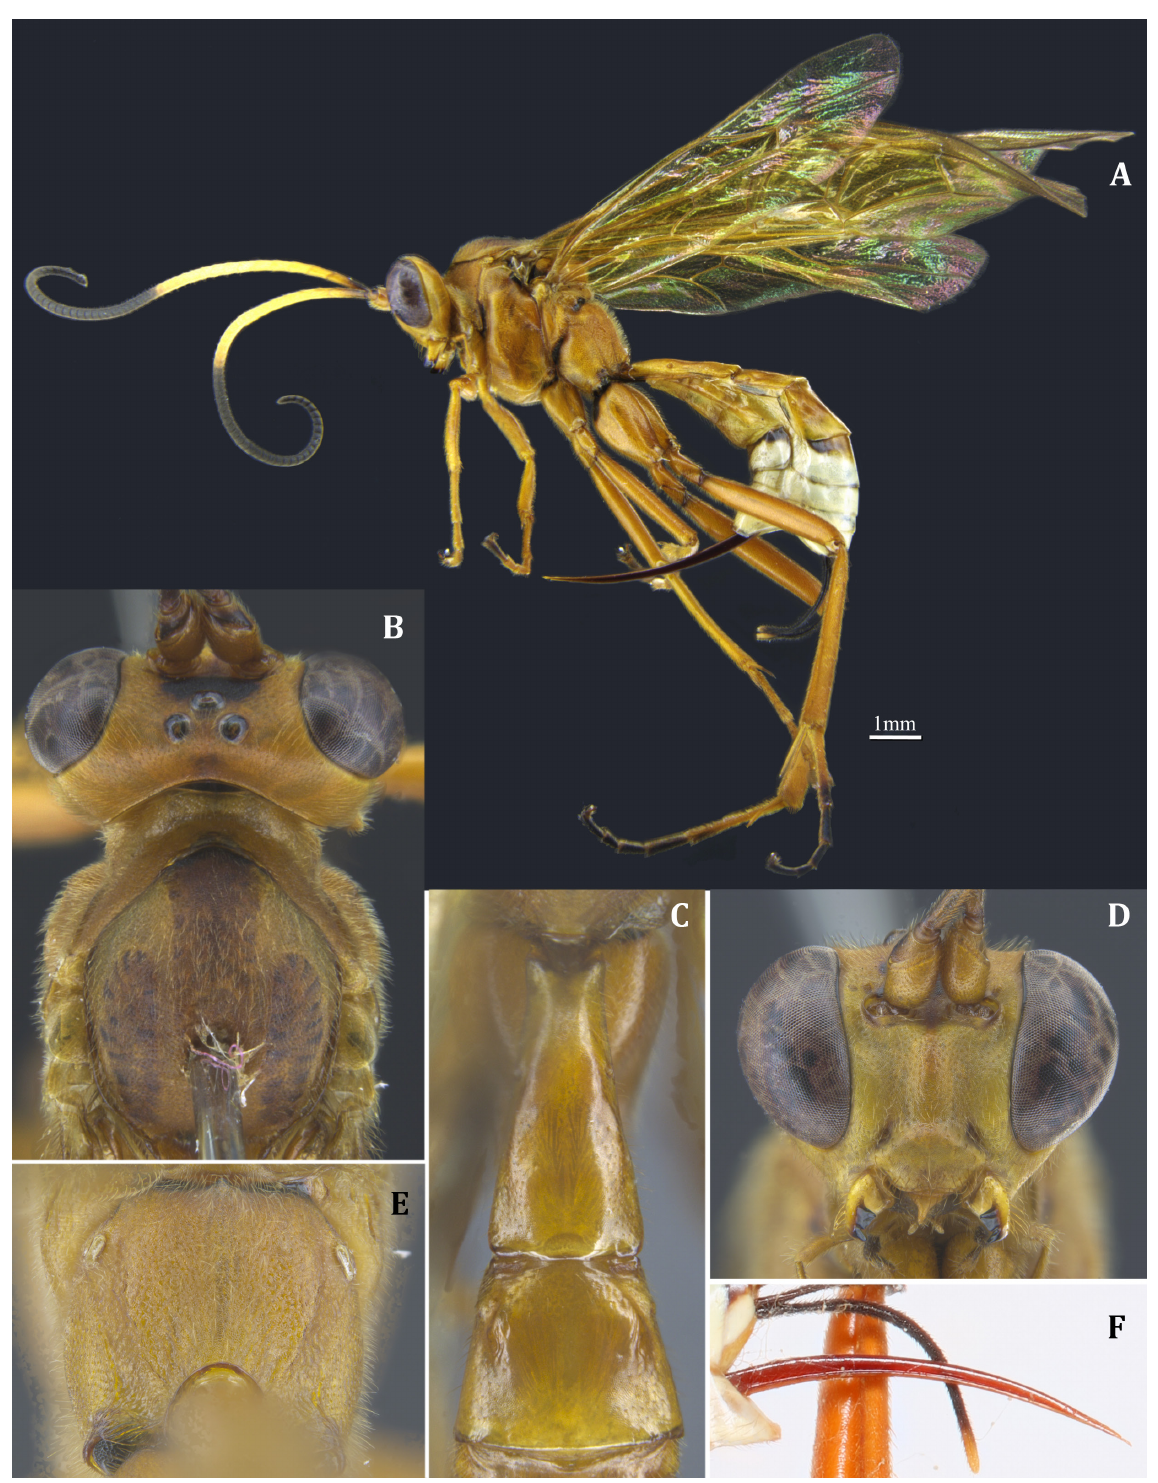
Fig. 2. Exetastes andensis sp. nov., holotype, ♀ (MUSM). A . Habitus, in lateral view. B . Head, in dorsal view and mesoscutum. C . T1–2. D . Face. E . Propodeum. F . Ovipositor. B–F not to